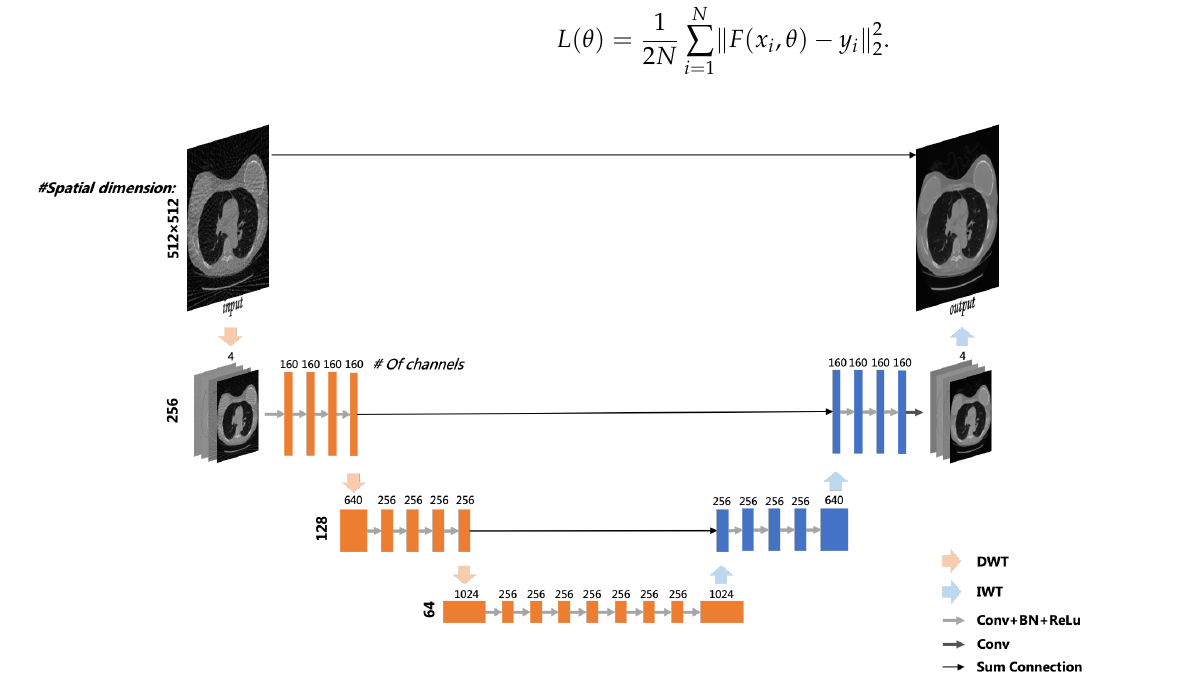
Figure 3. Multi-level wavelet CNN